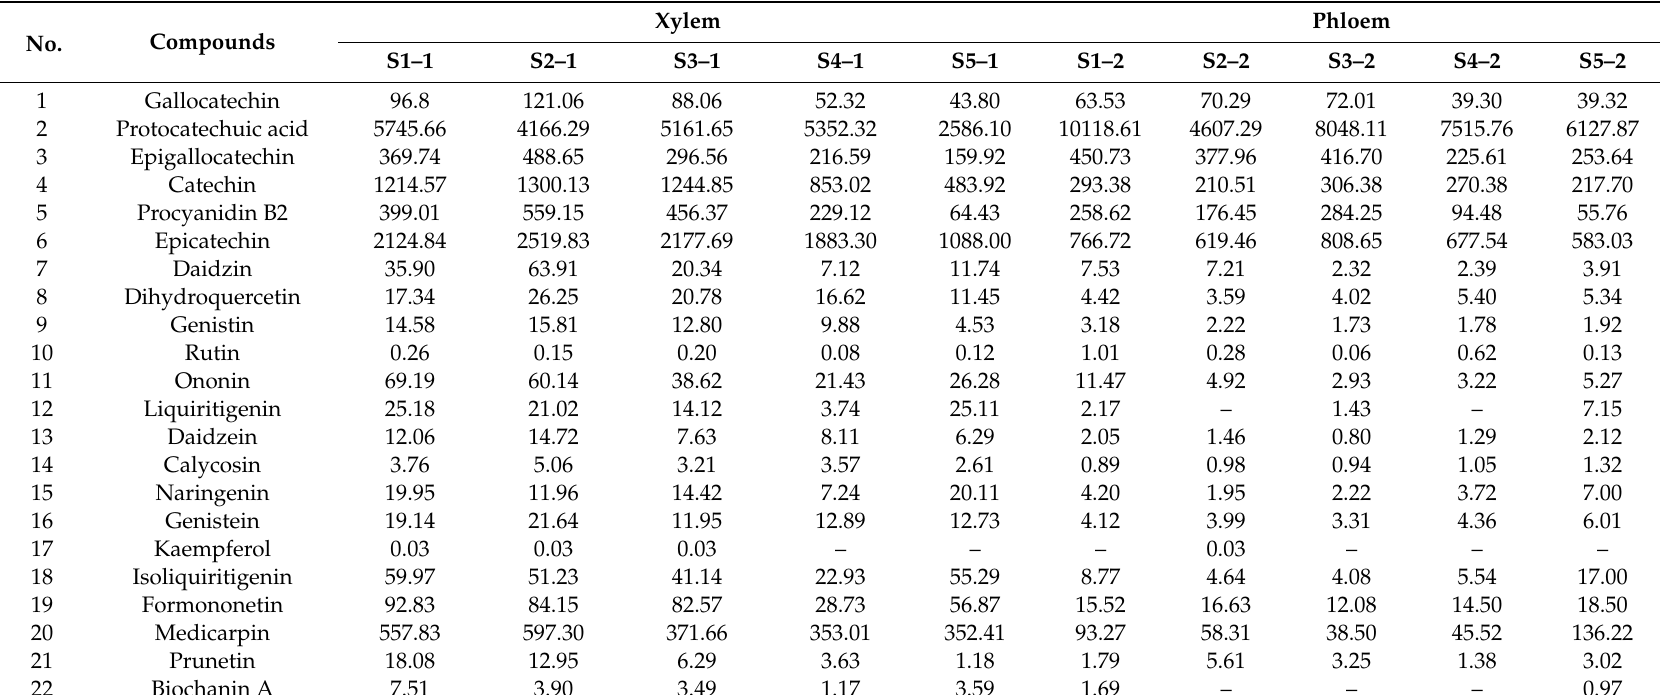
Table 3. Contents of 22 compounds in Spatholobi Caulis ( µ g / g, n =